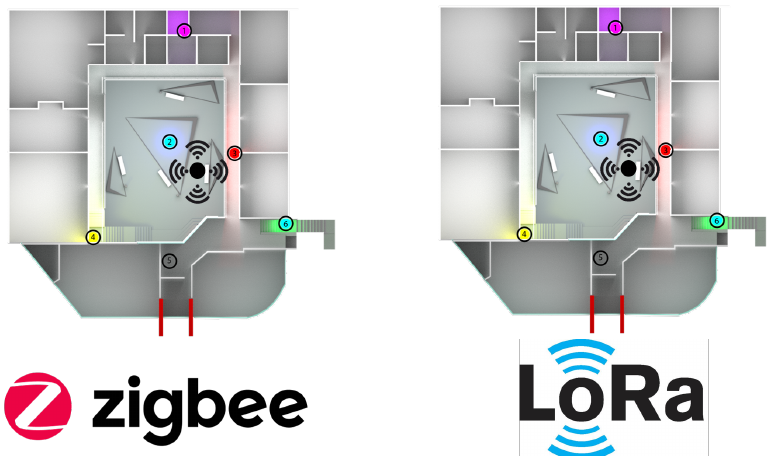
Figure 18. Top view of the real network deployment with the jammer node